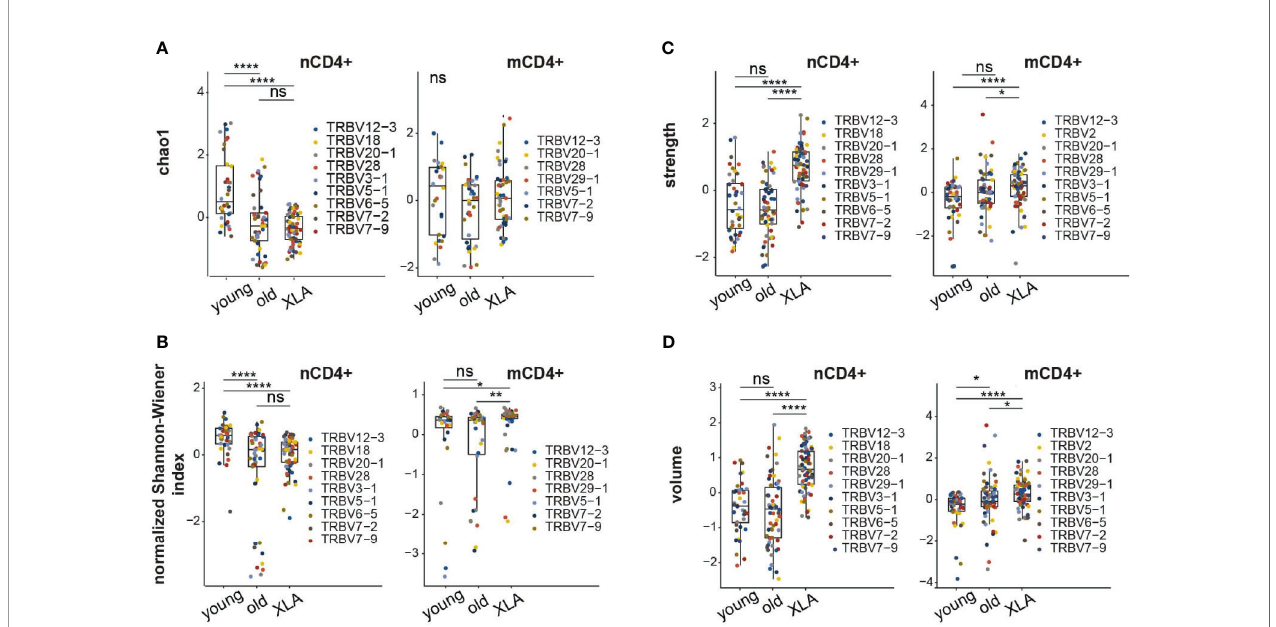
FIGURE 2 | Characteristics of memory and naïve CD4 + TCR repertoires in XLA and healthy donors. Analysis of repertoire diversity using the (A) Chao1 index and (B) normalized Shannon-Wiener index. (C) Clonotype interaction strength, as represented by the fraction of hydrophobic and aromatic amino acids, and (D) CDR3 b volume, based on bulky amino acids, in the central region of CDR3 from XLA (N = 7), and healthy young (N = 6) or old (N = 6) donors. All analyzed features were calculated for the most abundant V-segments extracted from full clonotype datasets. For diversity analysis, all segment sets were down-sampled to 1,000 randomly- chosen UMI-labeled TCR b cDNA molecules. Only segments with a suf fi cient number of UMIs were included. To exclude potential dependence of features from the V segment, all features within the same cell type and the same V segment were turned to Z-scores. Differences between groups were examined using the Kruskal- Wallis test followed by the Dunn test with the Benjamini-Hochberg correction. *p < 0.05, **p < 0.01, ****p < 0.0001, ns, non signi fi